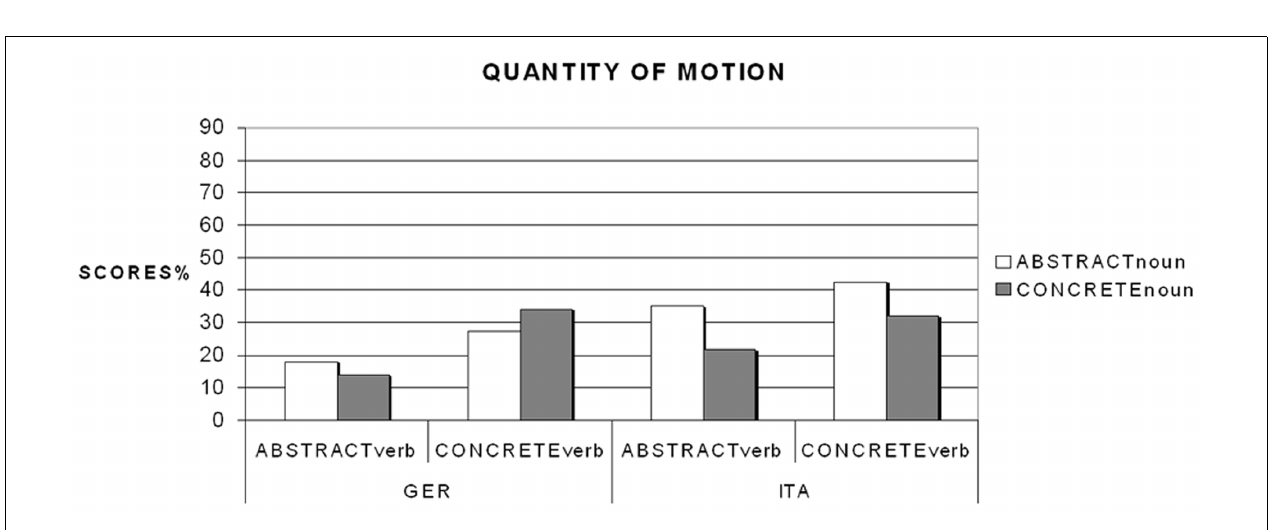
Verb plus Concrete Noun combinations: the former suggested the biggest amount of movement for Italian participants; the latter evoked the huger quantity of motion in German